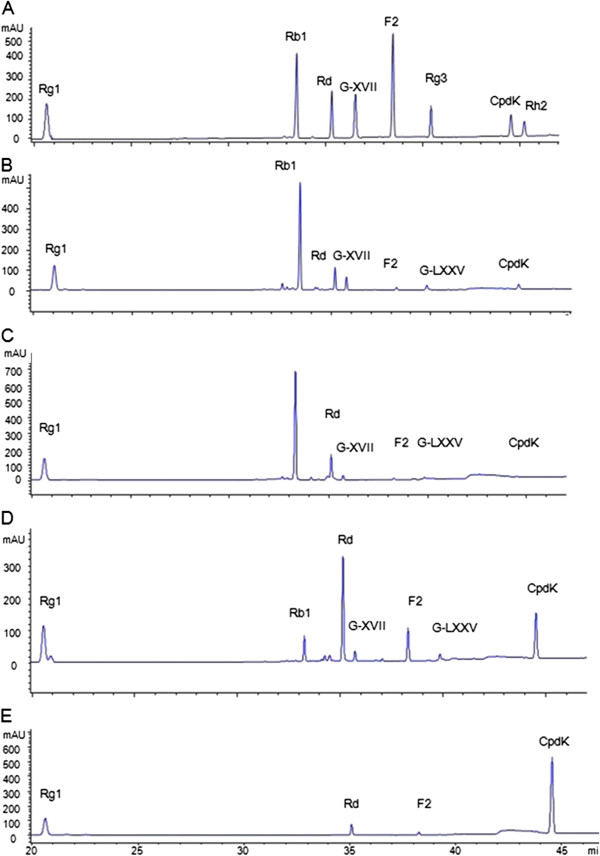
HPLC-UV chromatograms of (A) mixed ginsenoside standards, and incubated samples of Rb1 with (B) pooled gut bacteria and intestinal bacteria from (C) a 65-year-old male, (D) a 44-year-old male, and (E) a 54-year-old female. M1, ginsenoside Rd; M2, gypenoside XVII; M3, ginsenoside F2; M4, gypenoside LXXV; M5, compound K.